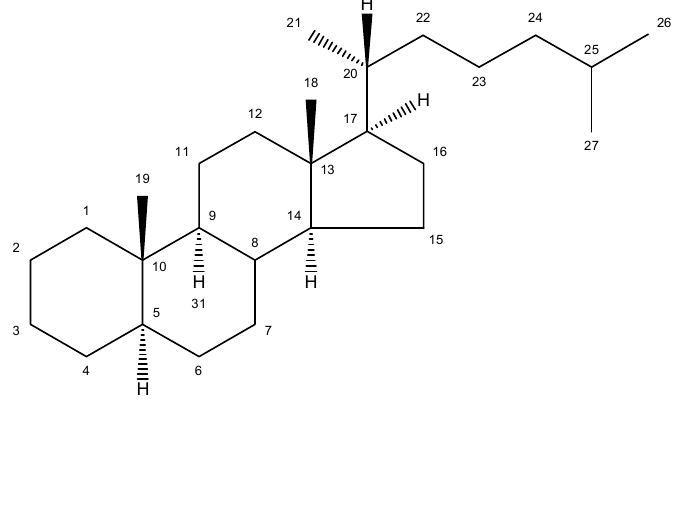
Figure 1. Chemical structure of 5 α -cholestane (20 R ) and the IUPAC-IUB recommendations for the atom